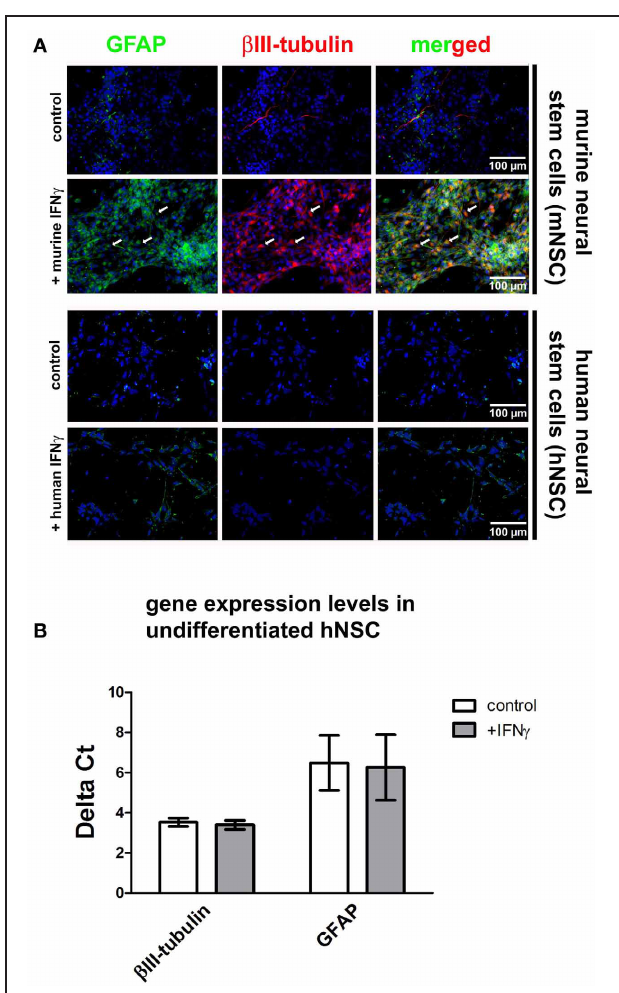
FIGURE 2 | Effects of IFN γ on hNSCs and mNSCs. In (A) photomicrographs of undifferentiated hNSCs (Wicell h9 line) and mNSCs are given. A β III-tubulin and GFAP co-staining under control conditions and after IFN γ treatment is shown. The upper to panels show mNSCs, the lower two panels show hNSCs. In mNSCs, IFN γ typically leads to a strong up-regulation of neuronal ( β III-tubulin) and glial (GFAP) markers with many cells simultaneously expressing both markers (arrows and the merged picture). In hNSCs no IFN γ -induced up-regulation of these markers was detected. In (B) gene expression levels of β III-tubulin, GFAP, and SHH in undifferentiated hNSCs (Wicell h9 line) either under control conditions or after IFN γ treatment are shown. The results demonstrate that there is, also on mRNA level, no IFN γ -induced up-regulation of cell type-specific markers.